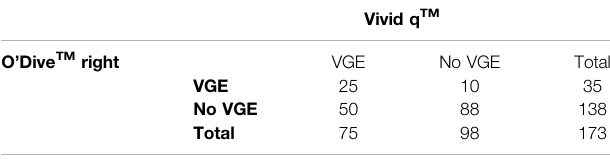
TABLE 6 | Contingency table showing venous gas emboli (VGE) presence agreement between the Vivid q TM and the O ’ Dive TM right measurement. The O ’ Dive ™ right measurement sensitivity was found to be 33.3% and its speci fi city 89.8%.